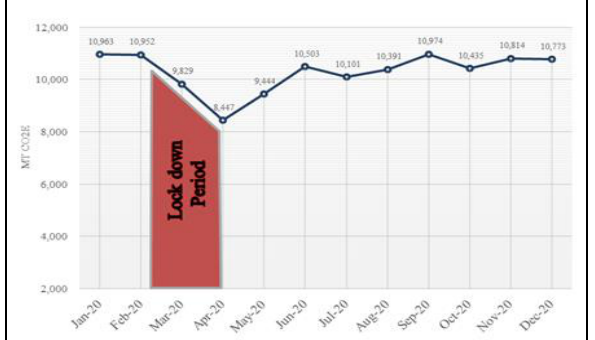
Figure 3. Monthly trend of the carbon footprint associated